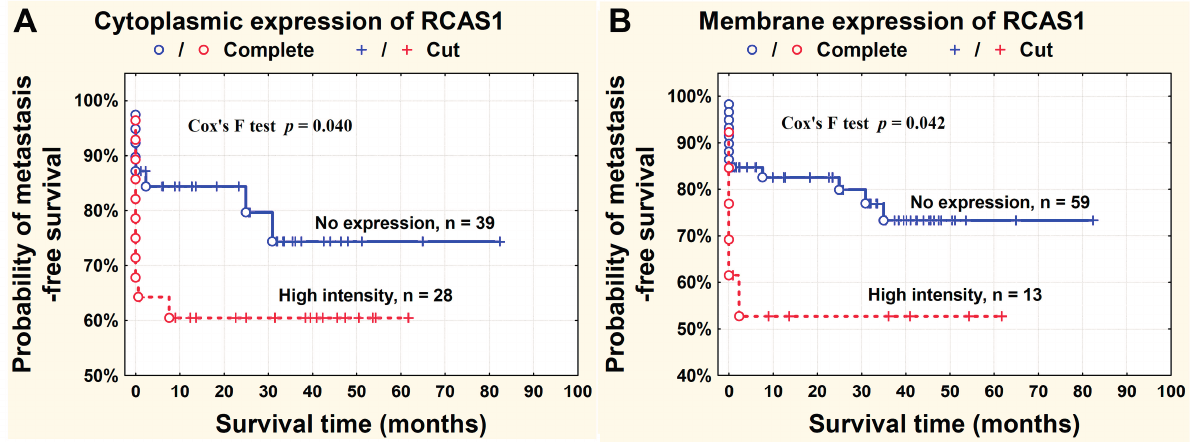
Figure 5. Probability of metastasis-free survival time in relation to the cytoplasmic ( A ) and membrane ( B ) RCAS1 expression in cancer cells in tumor border parts. Patients with regional (N+) and distant (M+) metastases were included into the analysis. 2.2. The Characteristics of TAMs and CAFs in the Microenvironment: RCAS1 Expression and Cell Number